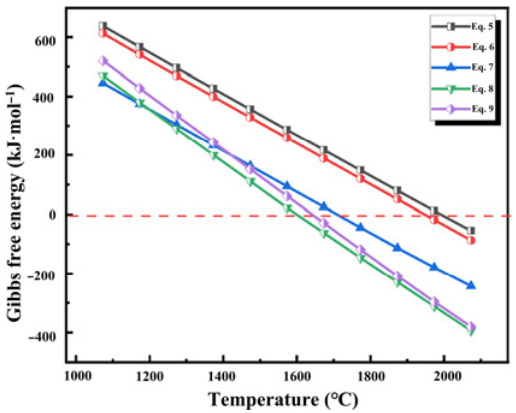
Fig. 7 Thermodynamic calculations of Eqs. (5)–(9).